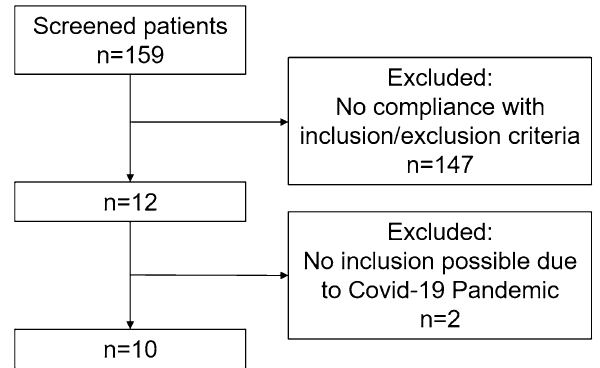
Figure 1. Flow chart for patient